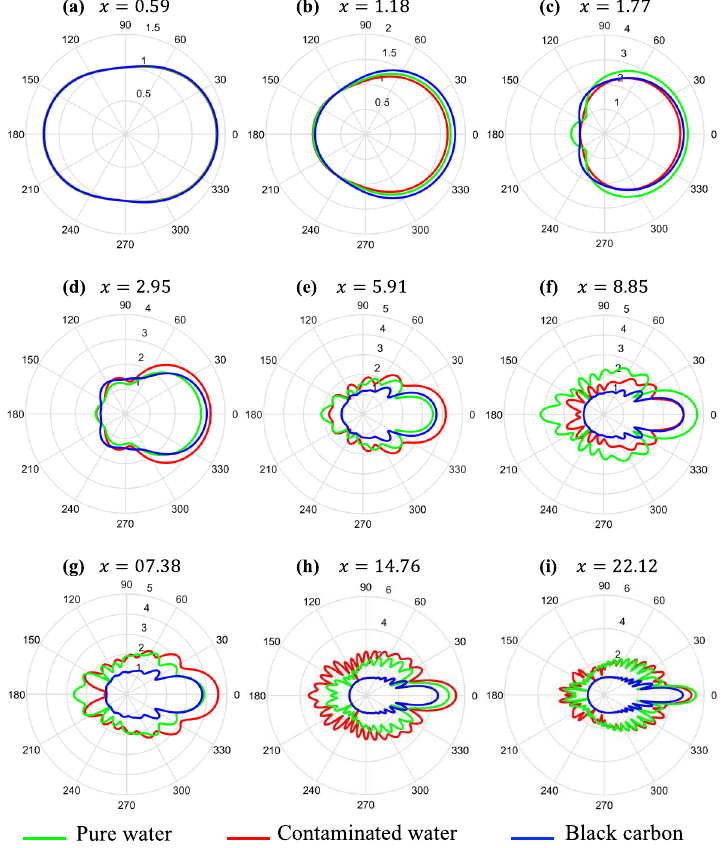
Figure 1. Mie angular scattering intensity patterns from pure water for each of the size parameters in Table 2: particle size of a = 0.1 µ m for ( a ) λ = 1.064 µ m, ( b ) λ = 0.532 µ m, and ( c ) λ = 0.355 µ m; a particle size of a = 0.5 µ m for ( d ) λ = 1.064 µ m, ( e ) λ = 0.532 µ m, and ( f ) λ = 0.355 µ m and a particle size of a = 1.25 µ m for ( g ) λ = 1.064 µ m, ( h ) λ = 0.532 µ m, and ( i ) λ = 0.355 µ